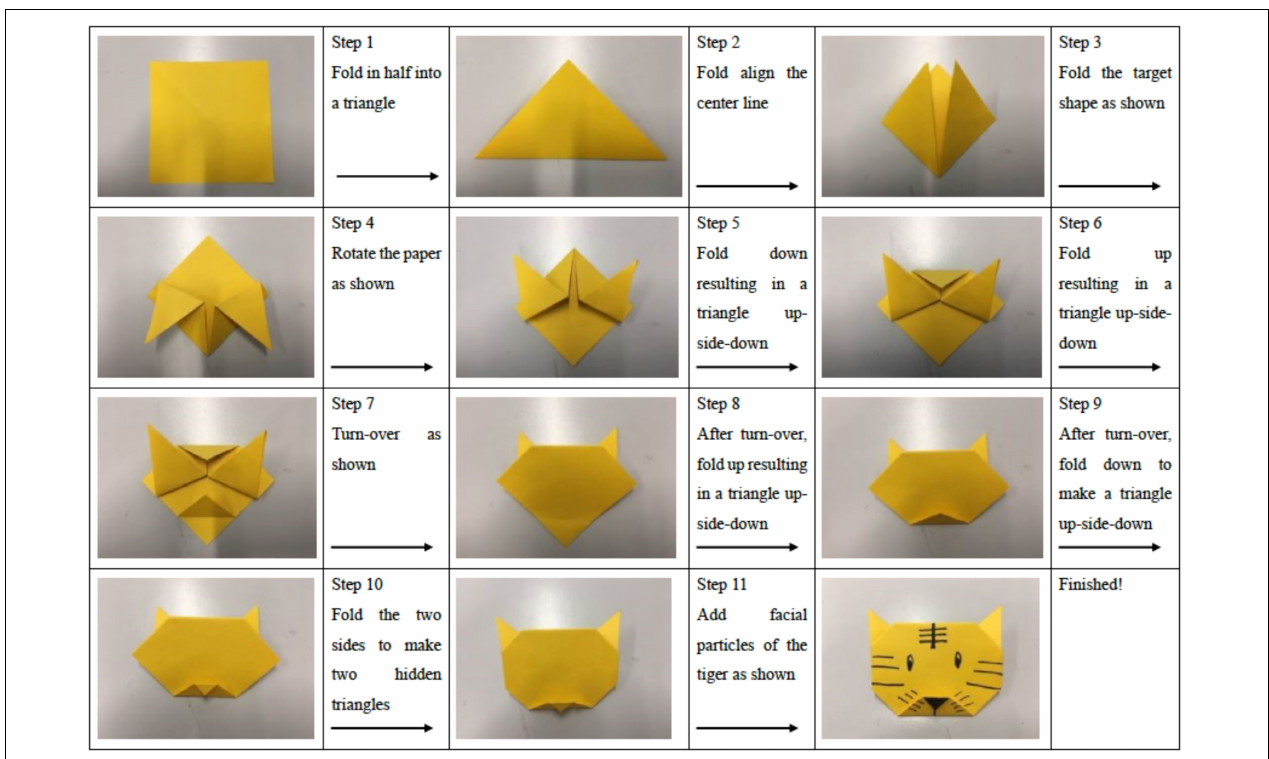
FIGURE 2 | The folding task (folding a tiger).